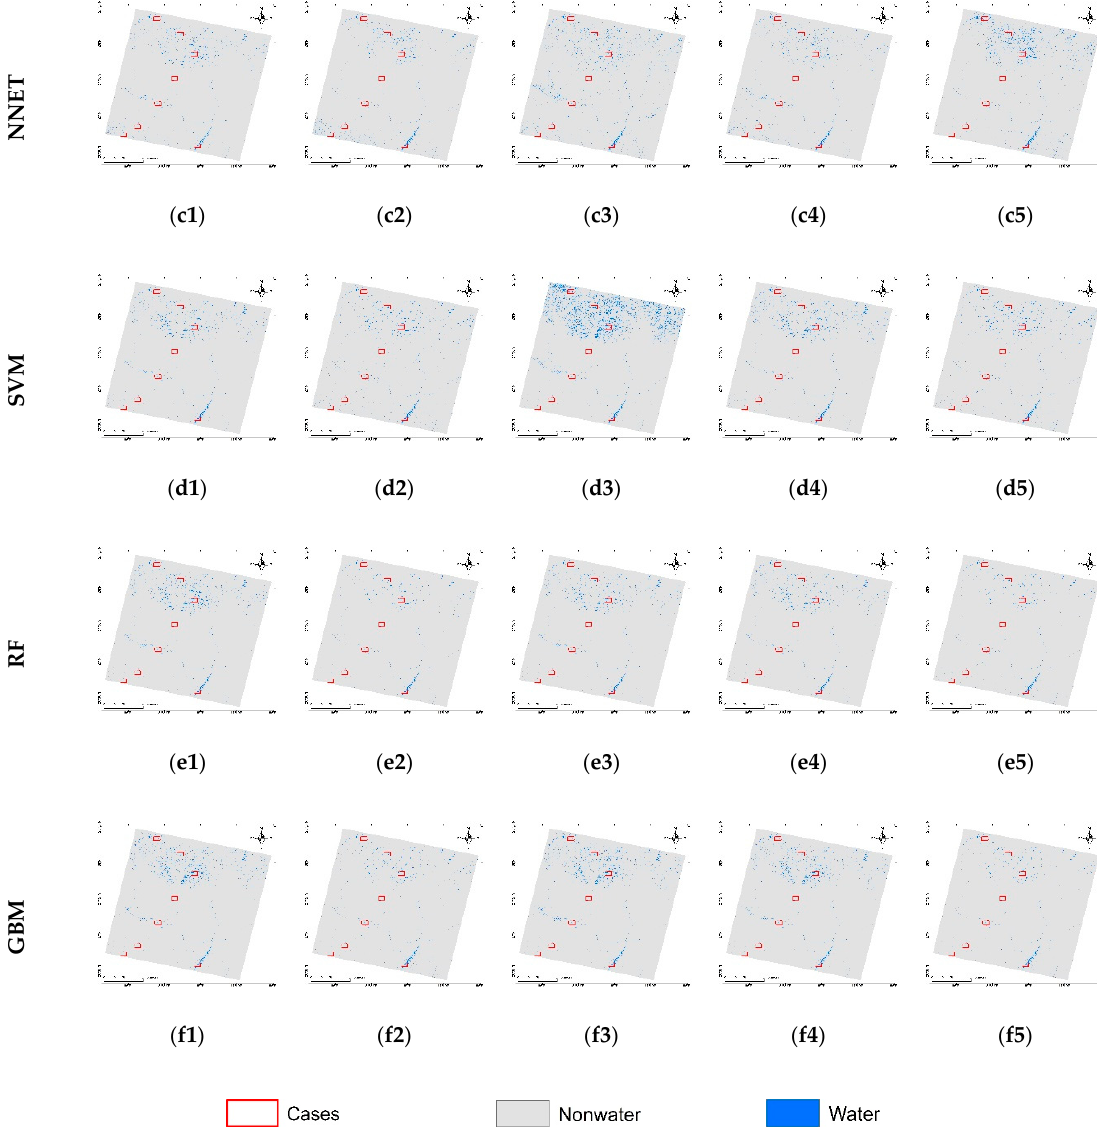
Figure 4. Results of surface water extraction using different machine learning methods ( a – f ) for provided multiband data ( 1 – 5 ).